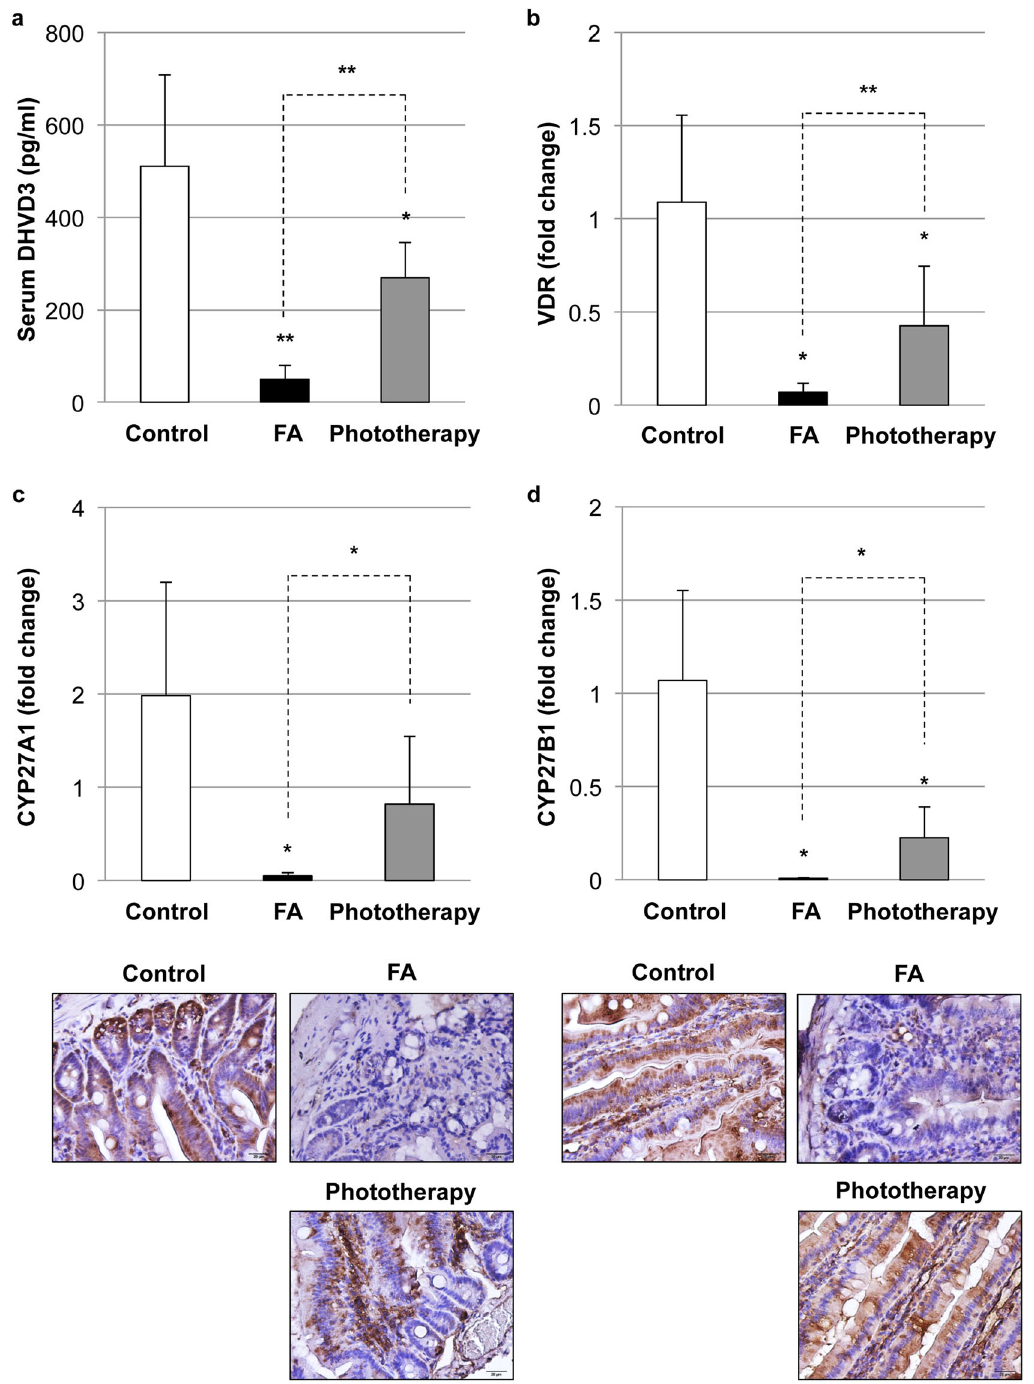
Fig. 4 Impact of phototherapy on vitamin D 3 metabolism in food allergy (FA). a Serum levels of vitamin D 3 were measured by ELISA. Values are presented as the mean ± SD of at least eight individuals in each group. *, **, P < 0.05 and 0.01 vs. the control or phototherapy group, respectively (Student ’ s t test). Intestinal levels of vitamin D receptor (VDR) ( b ), sterol 27-hydroxylase (CYP27A1) ( c ), and 25-hydroxyvitamin D 3 - 1 α hydroxylase (CYP27B1) ( d ) were evaluated by quantitative real-time PCR and immunohistochemistry (IHC). Values are presented as the mean ± SD of at least six individuals in each group. *, **, P < 0.05 and 0.01 vs. the control or phototherapy group, respectively (Student ’ s t test). The pictures at ×400 magni fi cation are representative of at least six individuals in each group. Scale bar: 20 μ expression levels of vitamin D 3 , CYP27A1, and CYP27B1 in control- existence of unique microbacteria in FA donor feces for the induction of the OVA-speci fi c IgE response and IgE-mediated FMT and phototherapy-FMT were relatively higher than those in allergic diarrhea. We also con fi rmed vitamin D 3 insuf fi ciency in all FA-FMT (Supplementary Fig. 6b). Although OVA challenge induced the elevation of intestinal IL-25, IL-33, and TSLP in all FMT groups, FMT groups (Supplementary Fig. 6b) due to the induction of the control-FMT and phototherapy-FMT groups had relatively dysbiosis by OVA challenge (data not shown). However, the